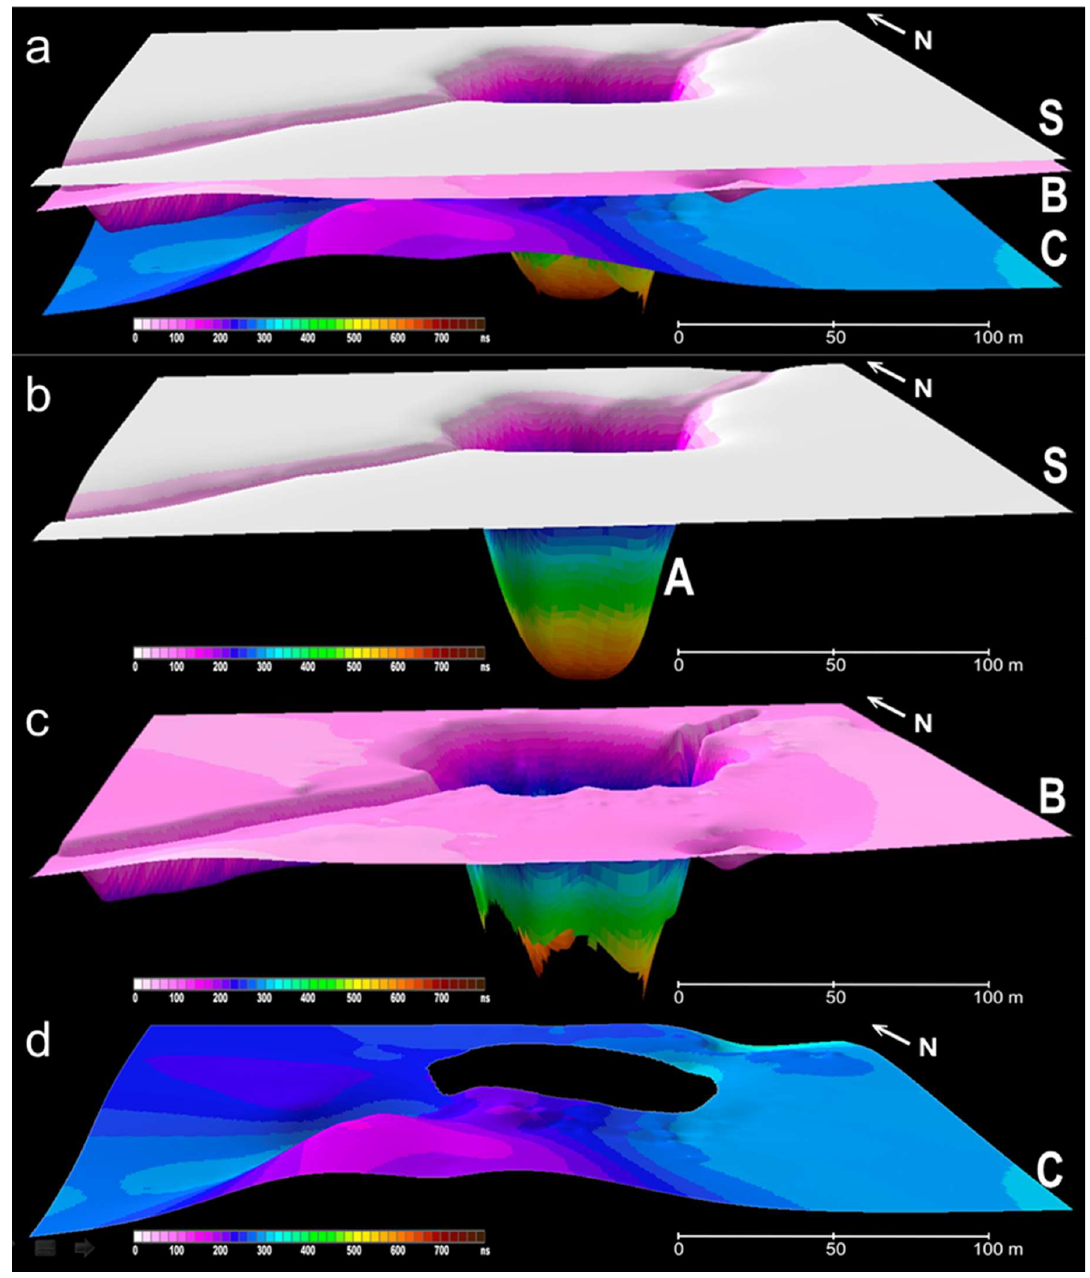
Figure 10. 3D model of the upper part of the sedimentary cover in the area of the C11 Crater based on GPR data with three horizons ( a ) and each horizon separately ( b–d ): A, the surface of the crater and the river bottom; S, the surface of the adjacent land area; B, the top of permafrost; C, reflecting horizon at the depth of 10–15 m (presumably, the base of the massive ground ice).